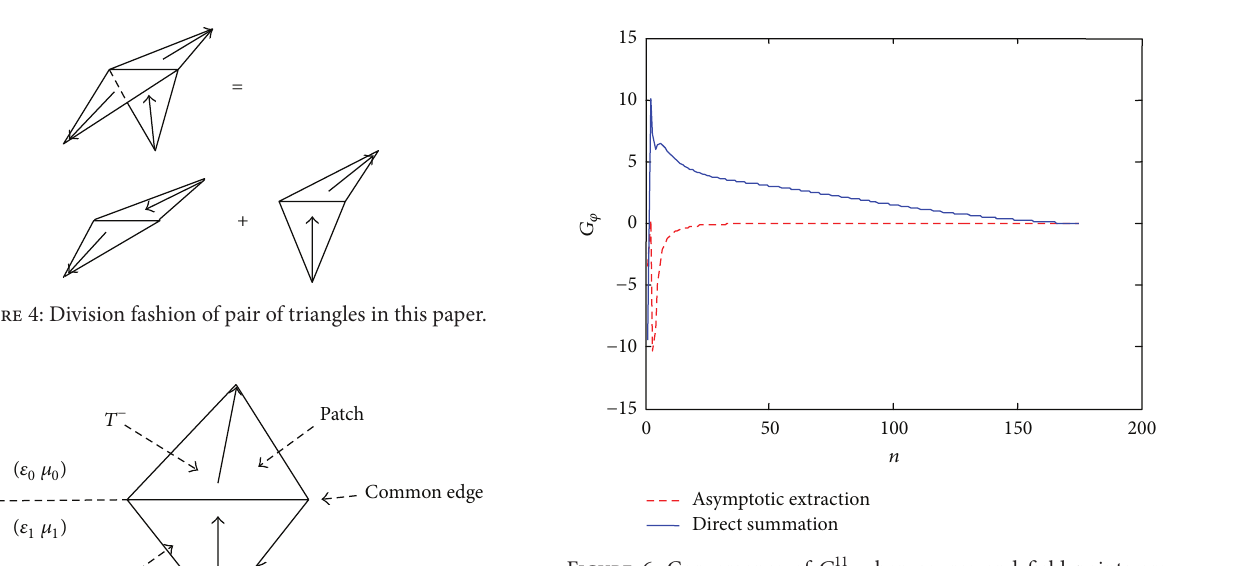
Figure 6: Convergence of 𝐺 11 𝜑 when source and field points are located in the same triangle at the